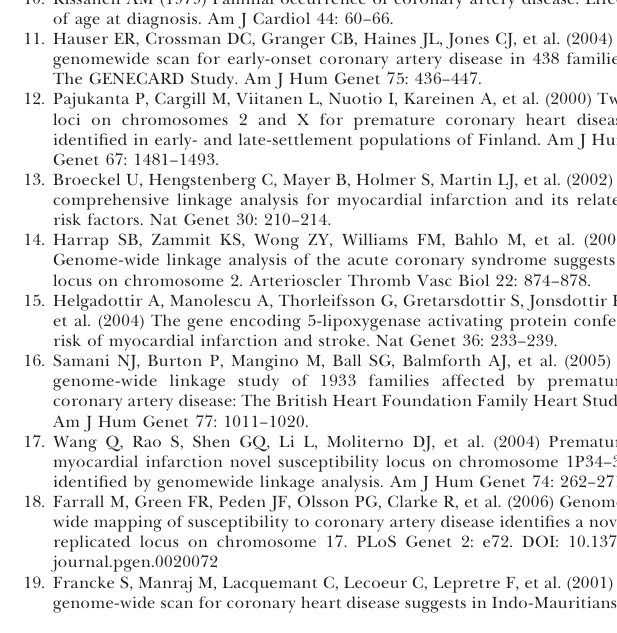
Table S1. Pairwise Haplotype Analysis within GENECARD Identifies Six Significant SNP Pairs in GATA2 Found at DOI: 10.1371/journal.pgen.0020139.st001 (19 KB XLS).